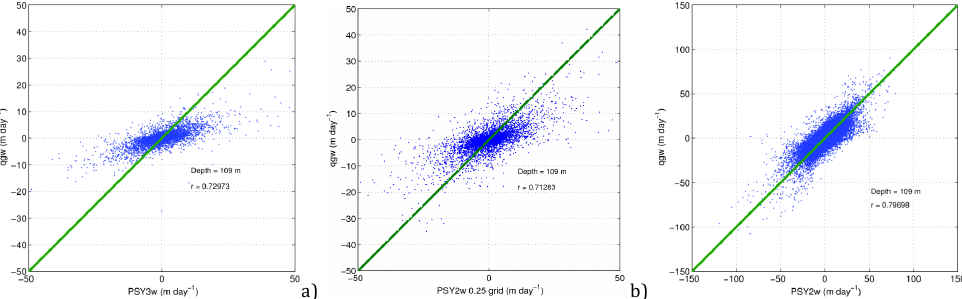
Fig. 12. Scatter plot between vertical velocity fields at 110m as obtained from primitive equation and quasi-geostrophic omega equation for (a) PSY3 (1/4 ◦ ) Mercator model, (b) PSY2 (1/12 ◦ ) Mercator model interpolated onto a 1/4 ◦ regular grid, and (c) PSY2 (1/12 ◦ ) Mercator